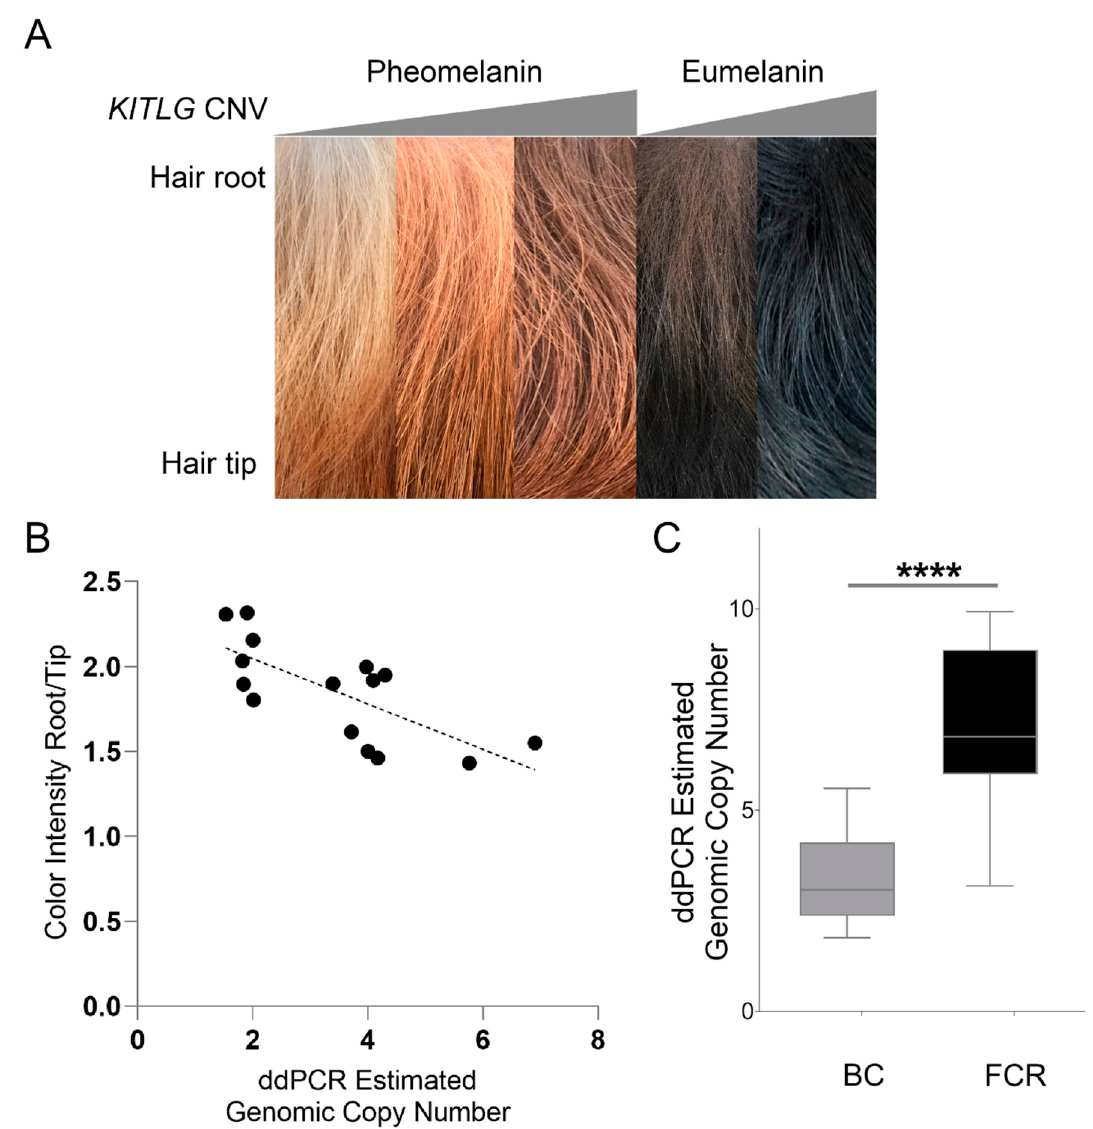
Figure 5. Hair sample quantification from pheomelanin and eumelanin-based breeds. ( A ) Representative hair samples from (left to right) low, medium, and high copy number NSDTR, and low and high copy number eumelanin-based dogs (BC and FCR). ( B ) Linear regression analyses revealed a significant association between an increased copy number and lower color intensity ratio between root and tip of hair in NSDTR (r 2 = 0.525, p = 0.0022, n = 15). ( C ) FCRs ( n = 20) have a significantly higher copy number in comparison to BC ( n = 26) in a ddPCR assay ( p = 3.9 × 10 − 9 ). The graph color represents the approximate hair color at the root of the hair shaft. **** = highly